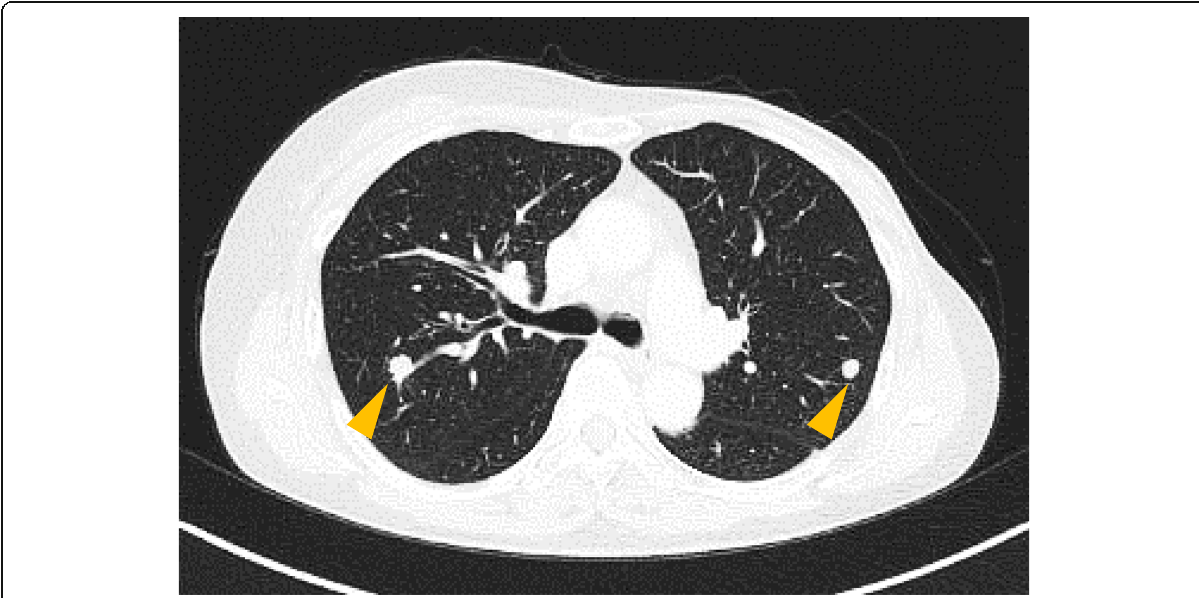
Fig. 4 Images of computed tomography (CT) at diagnosis showing lung metastasis. CT revealed two nodular masses located in the patient ’ s left upper and right upper lobes of the lungs (orange arrowheads)